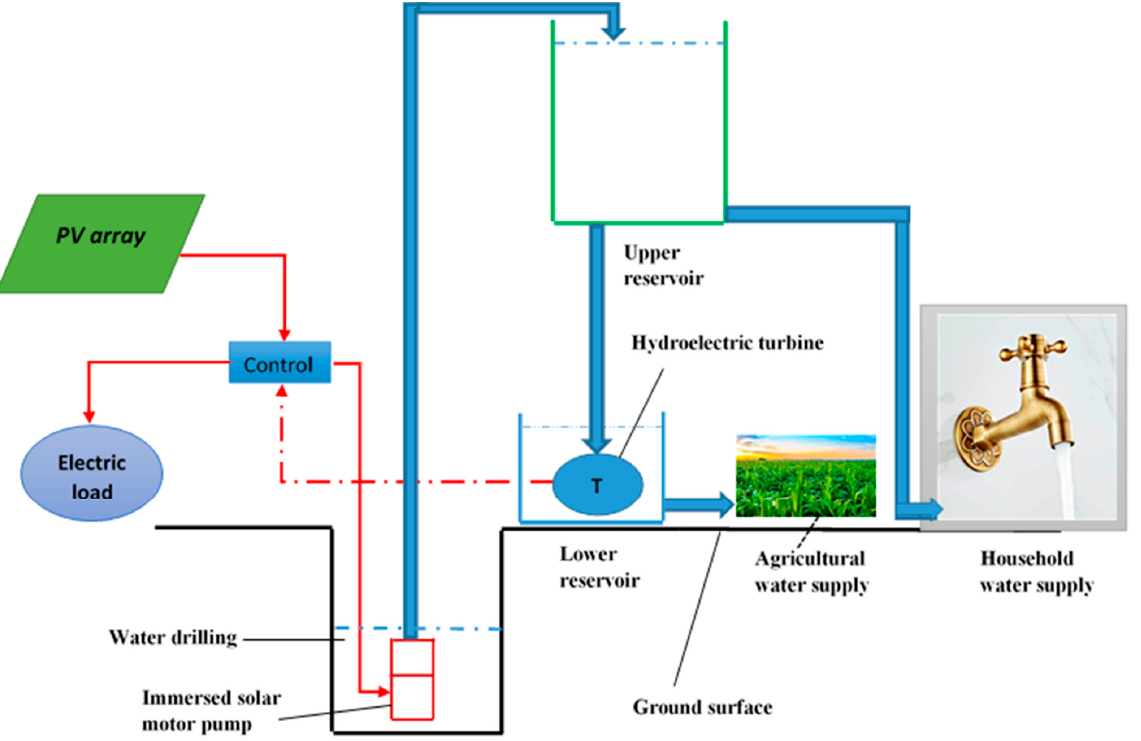
Figure 1. PV-system-based water pump energy storage for electricity and water supply.